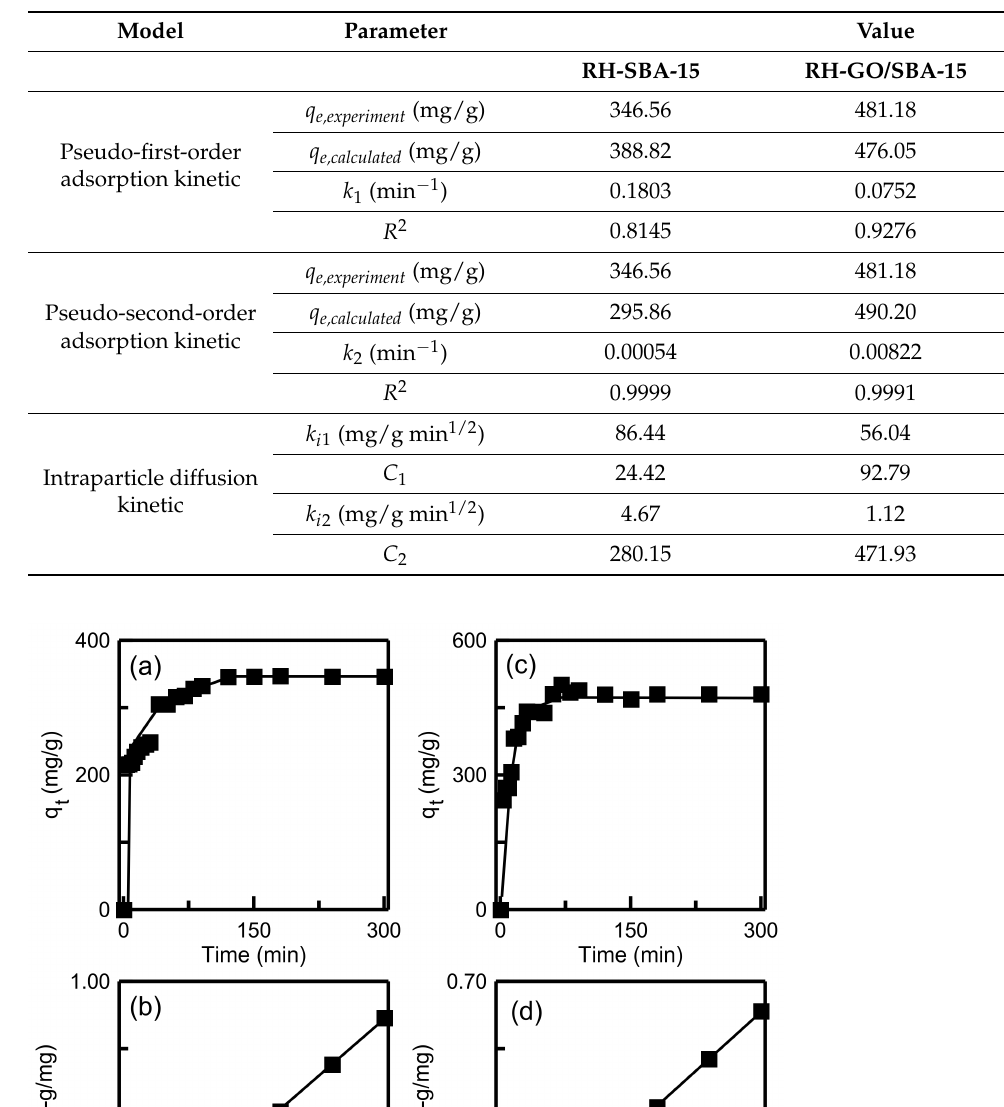
Table 5. Kinetics parameters for dye adsorption onto two types of adsorbents.